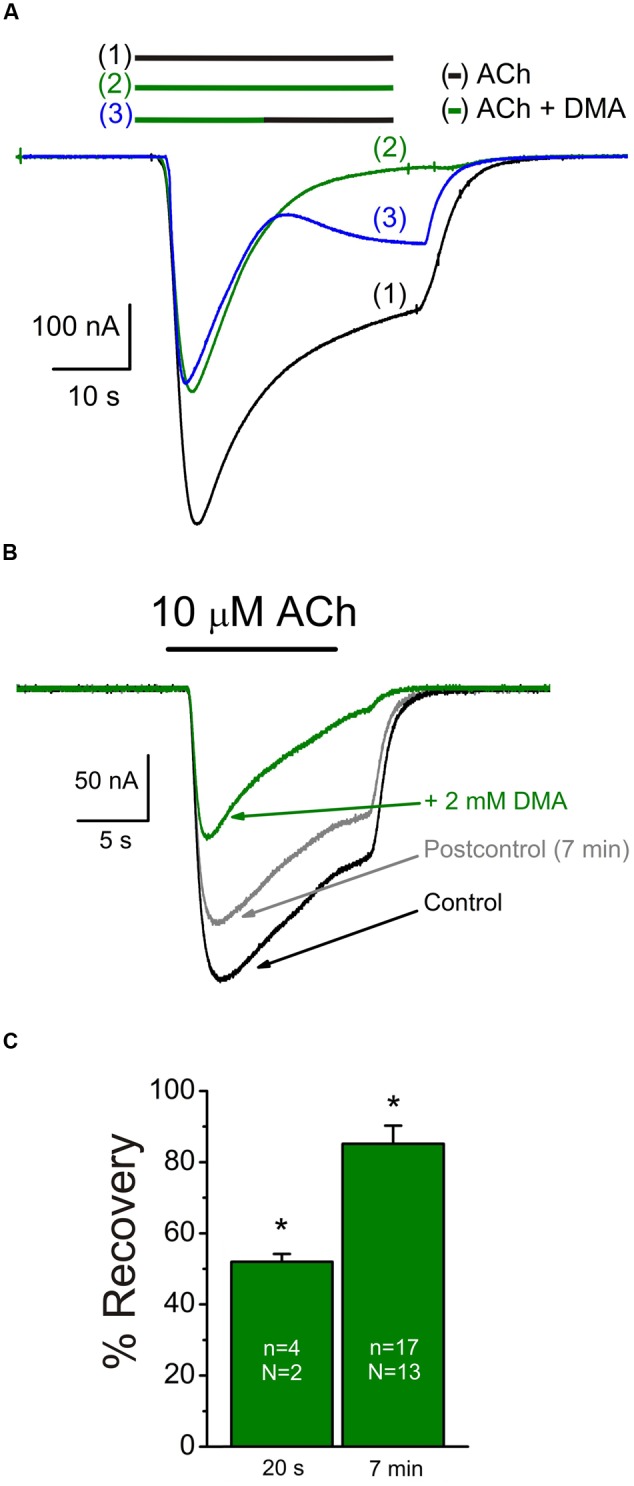
Slow recovery from nAChR blockade by DMA. (A) Superimposed IAChs evoked sequentially, in the same oocyte, by superfusing the cell with 10 μM ACh alone [(1), black bar and recording], co-applied with 2 mM DMA [(2), green bar and recording] or when changing from ACh plus DMA to ACh alone at the time indicated by the bars [(3), green followed by black bars and blue recording]. Note the incomplete recovery of IACh amplitude after washing DMA for 20 s. (B) Superimposed currents obtained by superfusing one oocyte with 10 μM ACh alone (Control, black recording) or plus DMA (+ 2 mM DMA, green recording). Seven min after DMA withdrawal (Postcontrol, gray recording), IACh did not fully reach the control amplitude. (C) Column graph showing the percentages of IACh recovery after 20 s or 7 min from DMA washout. Asterisks indicate significant differences respect to the control response.